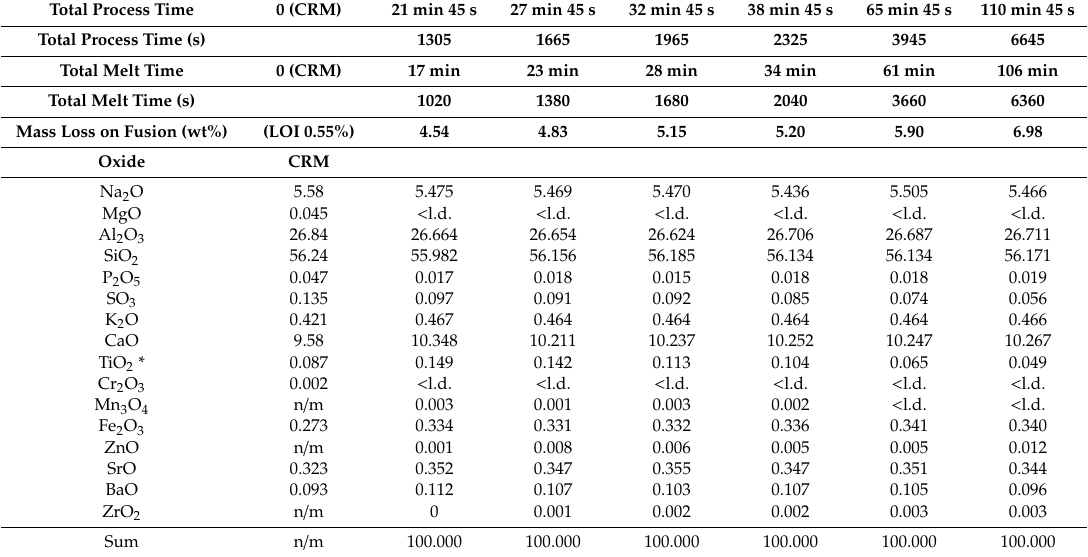
Table A1. XRF data for Anorthic Feldspar (CRM-529, [41]) as a function of total process and melt times. Data are single measurements; < l.d. = below limit of detection; n / m = not measured; * analysed TiO 2 content includes contribution from I L β 1,2,3